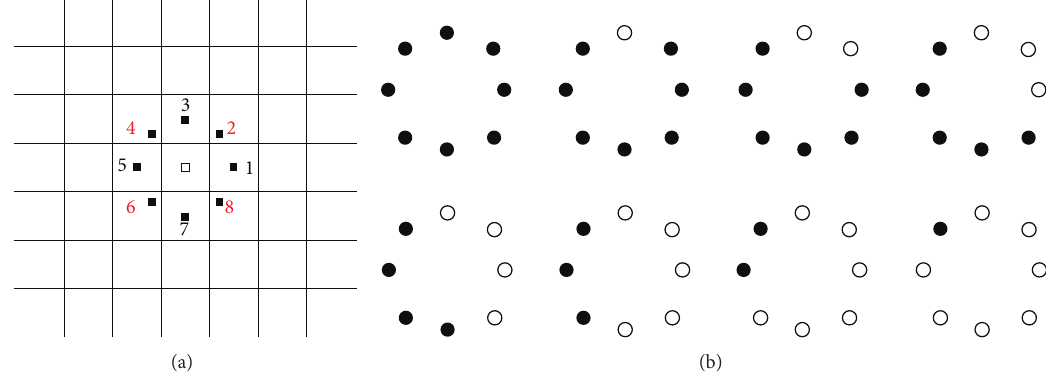
Figure 1: Feature extraction using HOG and LBP.